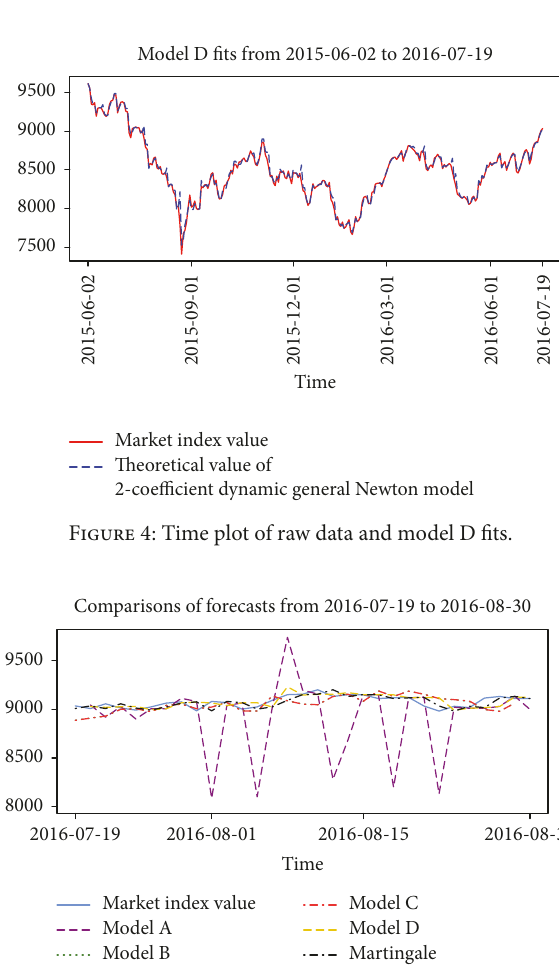
Figure5:Timeplotofrawdataandtheforecastsofthefourdynamic models and the